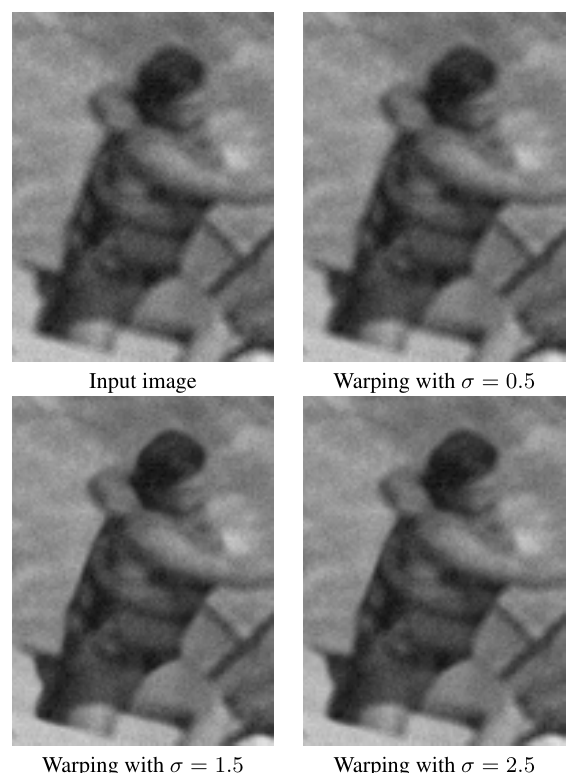
Figure 5. Examples of blurred and noisy images from the dataset.